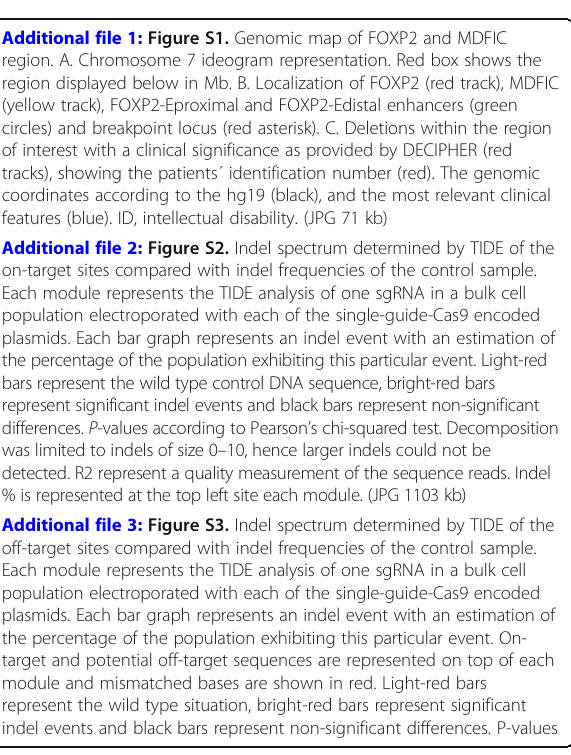
according to Pearson ’ s chi-squared test. Decomposition was limited to indels of size 0 – 10, hence larger indels could not be detected. R2 represent a quality measurement of the sequence reads. Indel % is represented at the top left site each module. (JPG 1041 kb) Additional file 4: Figure S4. PCR analysis. Two oligos flanking the deleted regions were used to amplify the genomic DNA from several mutant representative HEK293 and SK-N-MC clones. Black triangles show the size of the PCR products. Black or white asterisks show respectively the clones harbouring a homozygous or heterozygous deletion included in this study. M: molecular weight marker, WT/WT: wild type, Δ / Δ : homozygous deletion, WT/ Δ : heterozygous deletion. (JPG 1181 kb) Additional file 5: Figure S5. RT-qPCR analysis of six HEK293 cell clones with FOXP2-Eproximal or FOXP2-Edistal deletions. Samples are normalized to the average FOXP2 (left) or MDFIC (right) signal between three HEK293 replicates transfected with the pLV-U6 #x H1 #y -C9G empty vector. Levels of expression of FOXP2 and MDFIC are represented by the fold change relative to that of empty vector control cell line, which were normalized to 1. WT/WT: wild type, Δ / Δ : homozygous deletion, WT/ Δ : heterozygous deletion. (JPG 373 kb) Additional file 6: Figure S6. Detailed view of an ENCODE UCSC genome-browser snapshot showing bar graphs with a detailed representation of the locations of FOXP2 and MDFIC genes, H3K27Ac and DNA clusters in human cell lines. The squared regions in black show the locations of FOXP2-Eproximal and FOXP2-Edistal. The red squared tracks show the alignment result between humans and bats. (JPG 761 kb) Additional file 7: Table S1. Oligonucleotide and sgRNA sequences used in this study. (DOCX 15 kb) Abbreviations CRISPR: Clustered regularly interspaced short palindromic repeats; eRNAs: enhancer RNAs; GFP: Green fluorescent protein; INDEL: Insertion or deletion; iPS: induced pluripotent stem (cells); qRT-PCR: real-time quantitative RT-PCR; TAD: Topologically associating domain; UTR: Untranslated